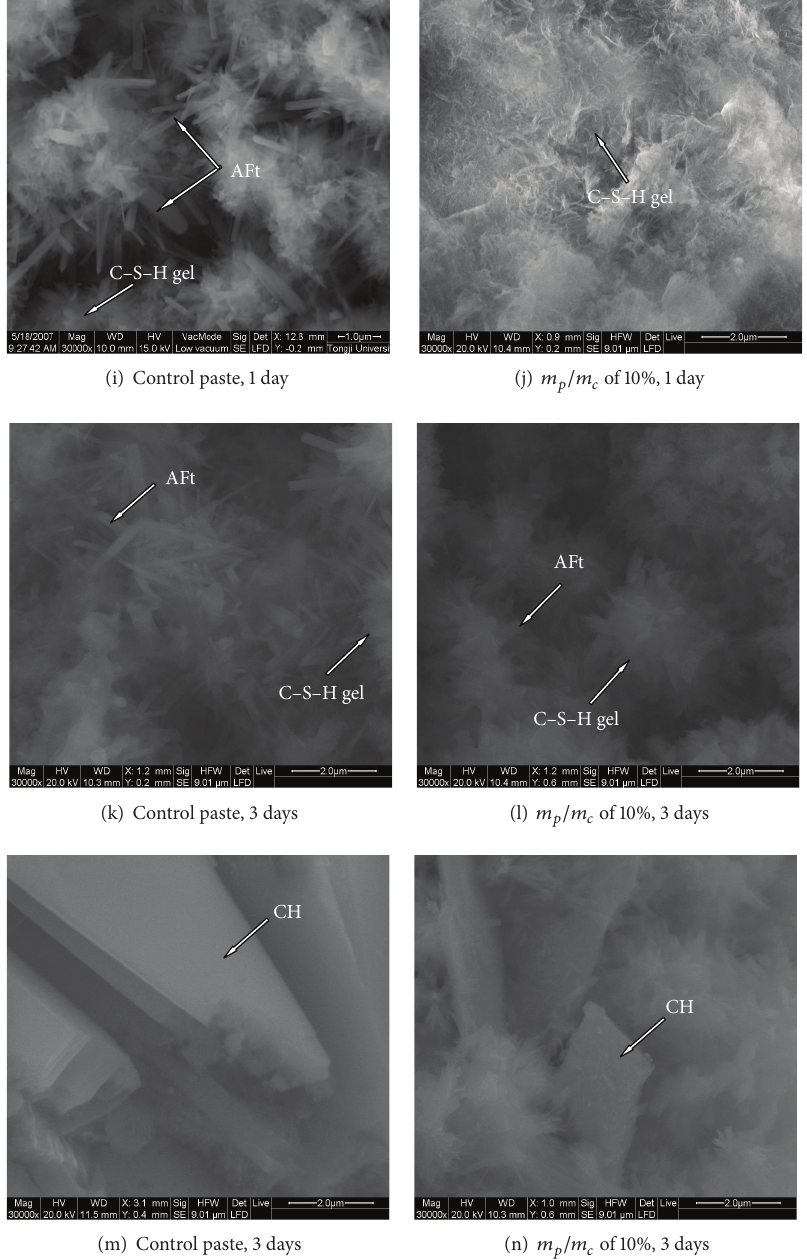
Figure 5: Second electron images of cement pastes in different ages observed by